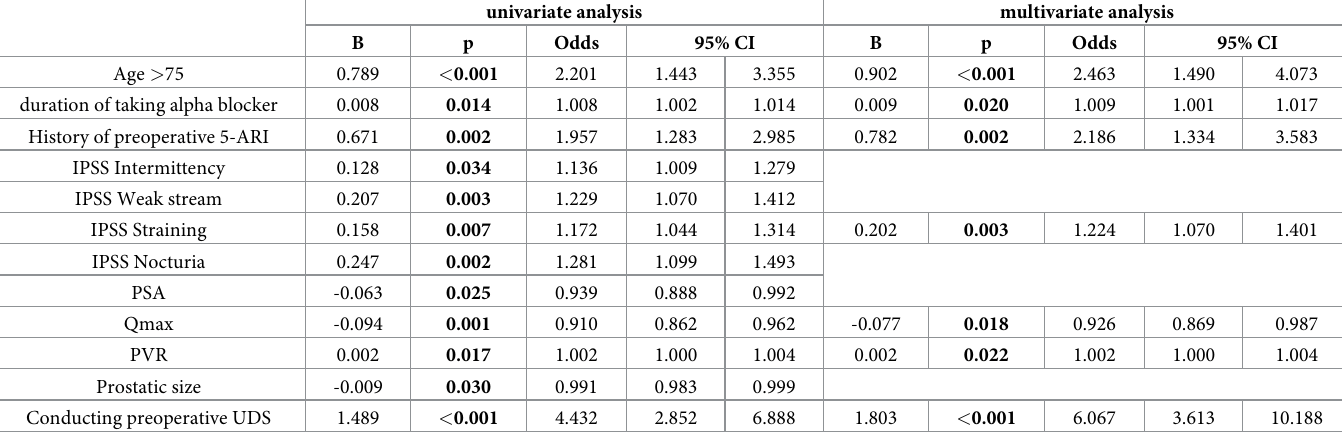
Table 2. Logistic regression analysis examining the relationship between baseline characteristics and taking alpha blockers continuously at 12 months